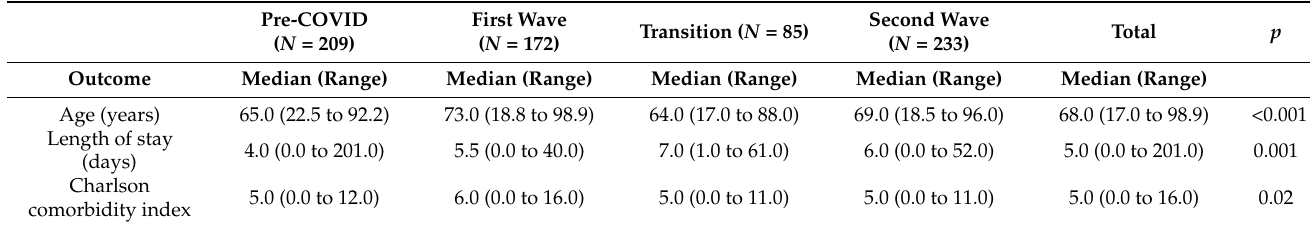
Table 2. Length of stay and Charlson comorbidity